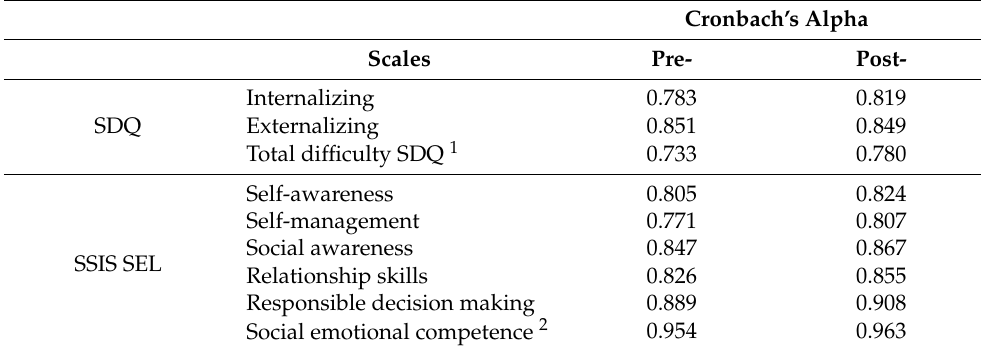
Table 2. Internal consistency of SDQ and SSIS-SEL in pre- and